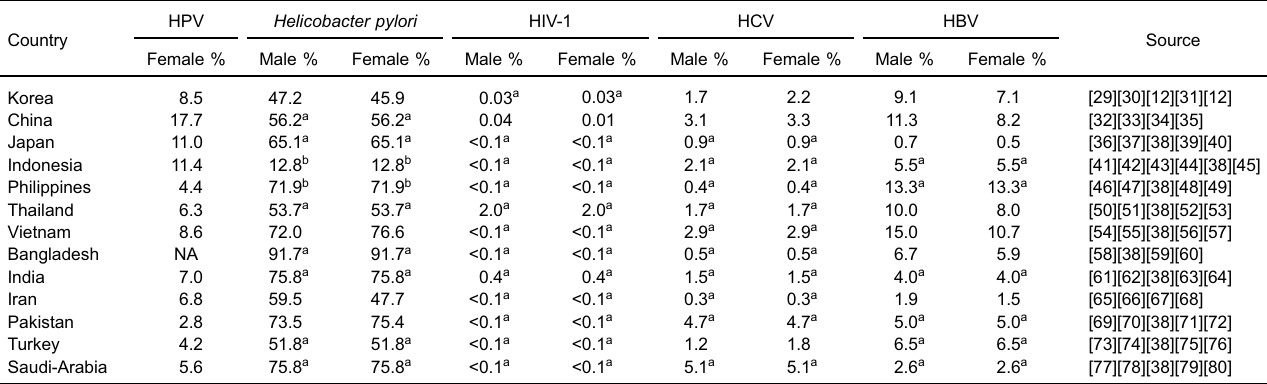
Table 3. Gender-speci fi c prevalence of infectious agents in the general population and data source, by country HPV Helicobacter pylori Country Korea